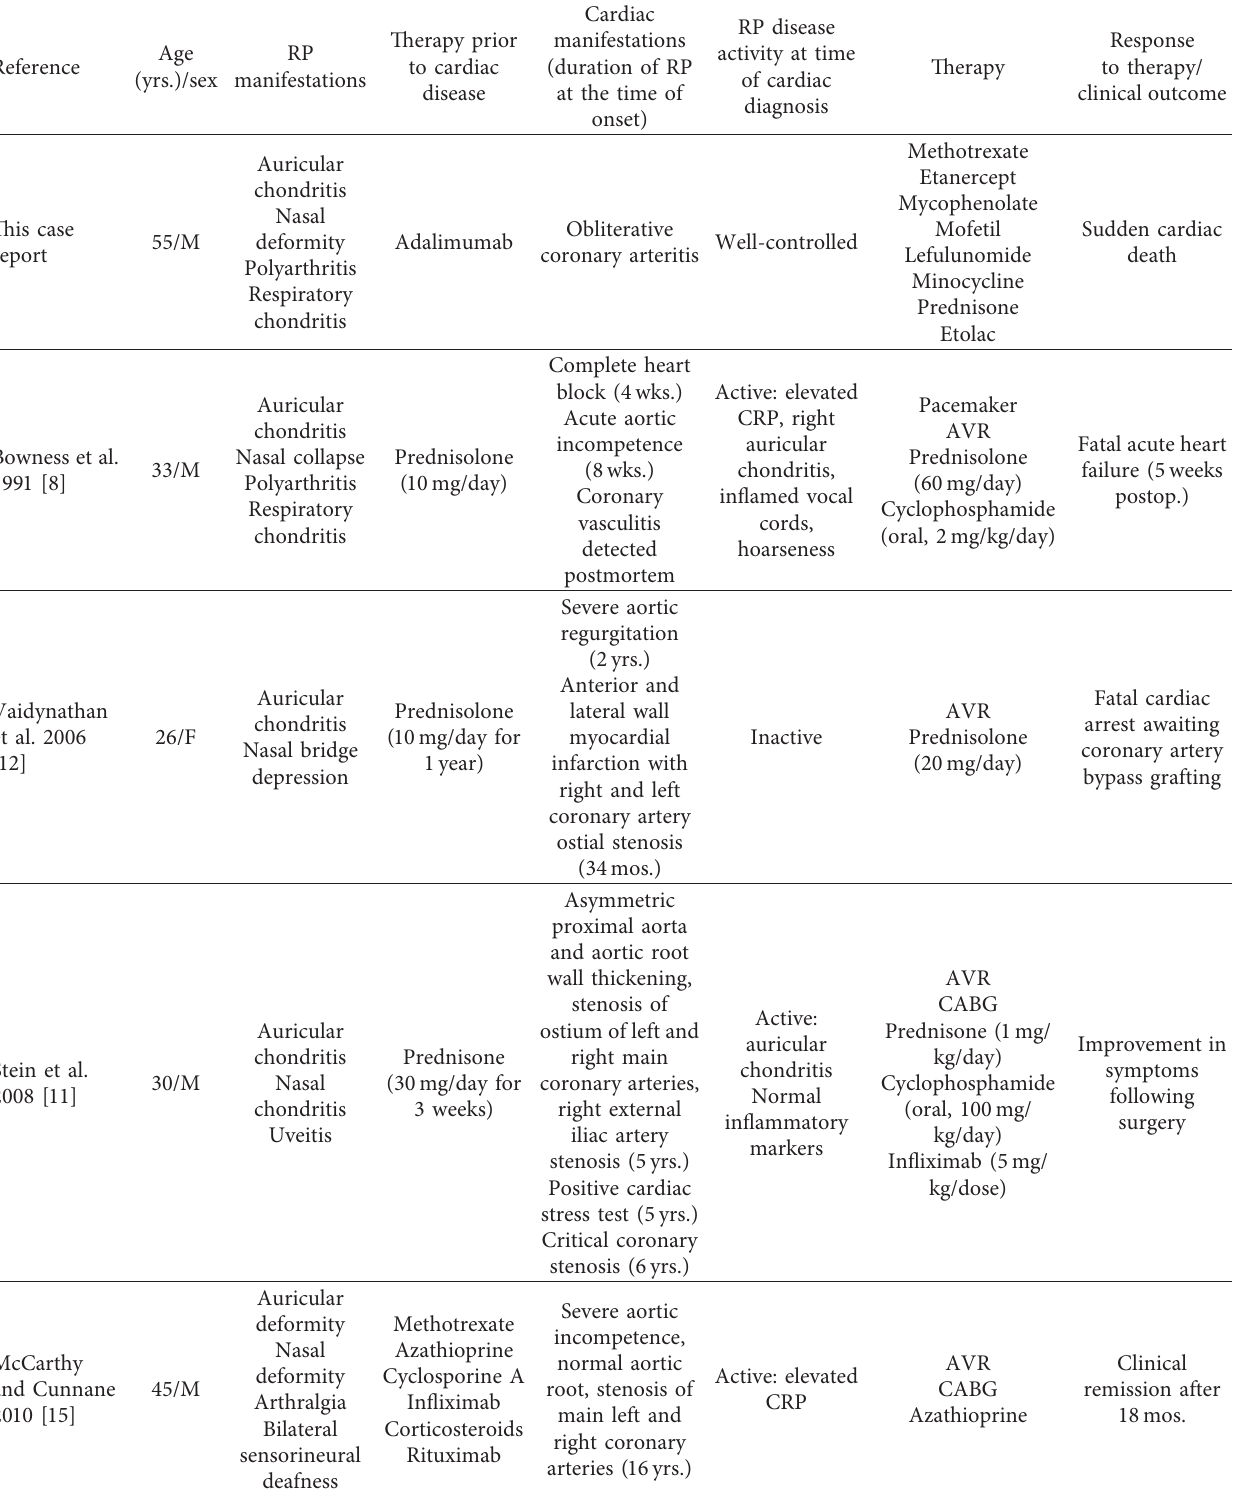
Table 1: Comparison of our patient with five published case reports describing RP with concomitant coronary artery disease.